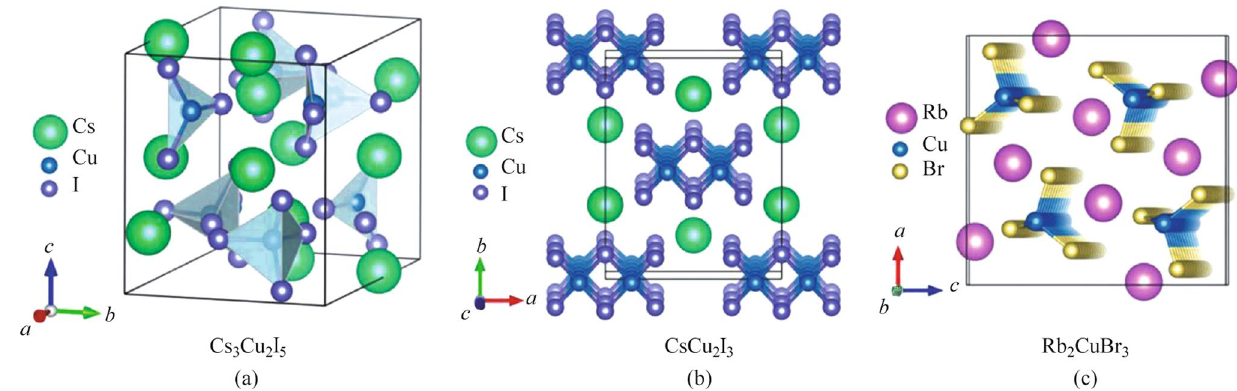
Fig. 1 Crystal structures of copper-based metal halides: a Cs right 2021, Royal Society of